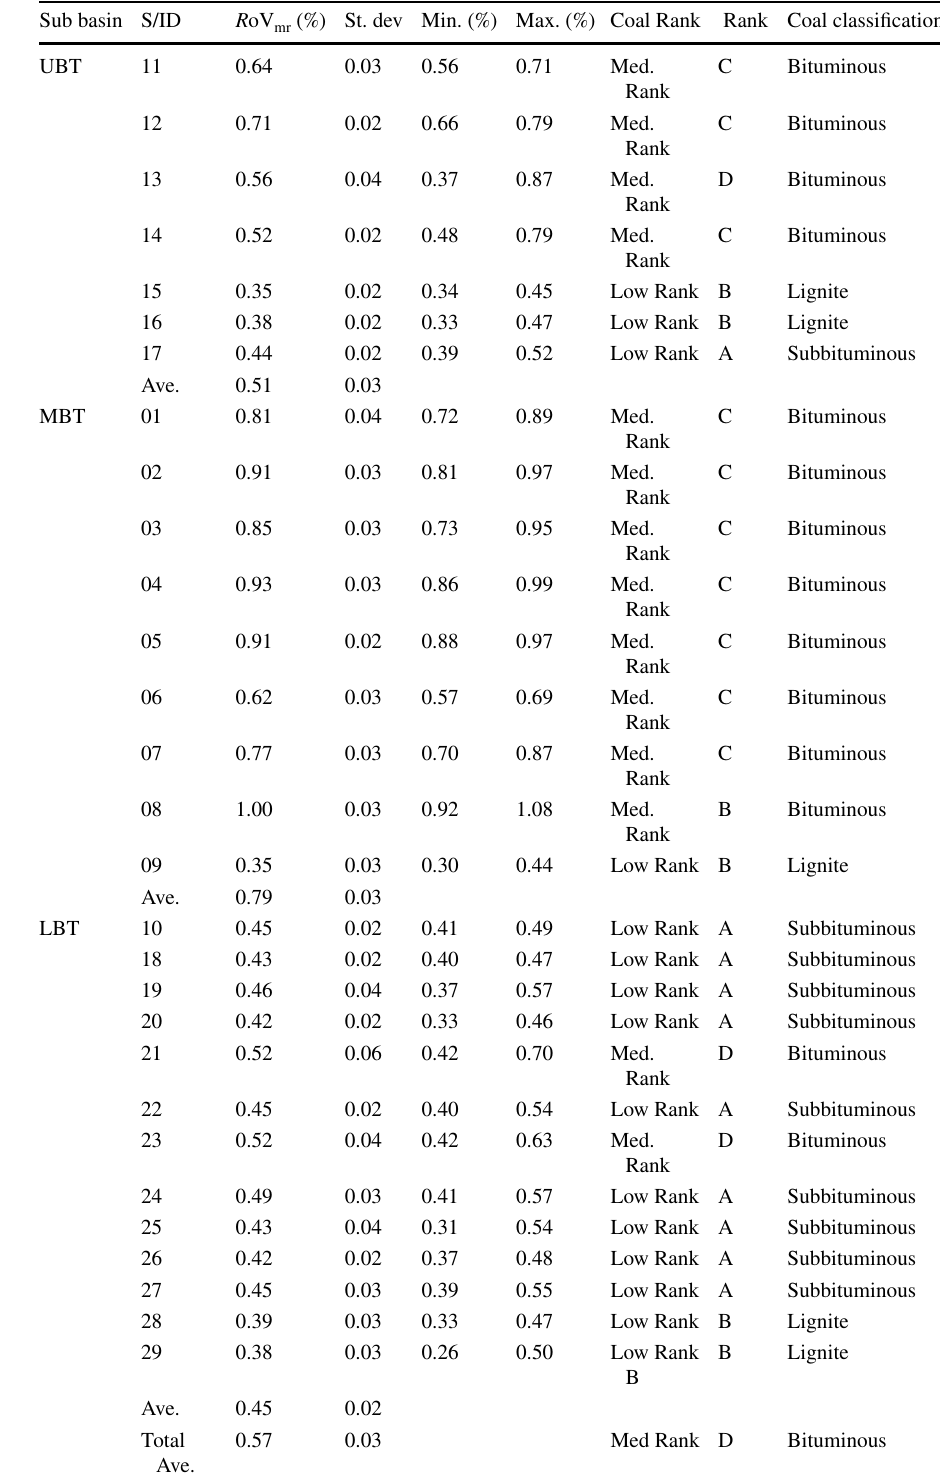
Table 4 Vitrinite reflectance data ( R oV mr %) (min. refers to minimum reading obtain; max. refers to maximum reading